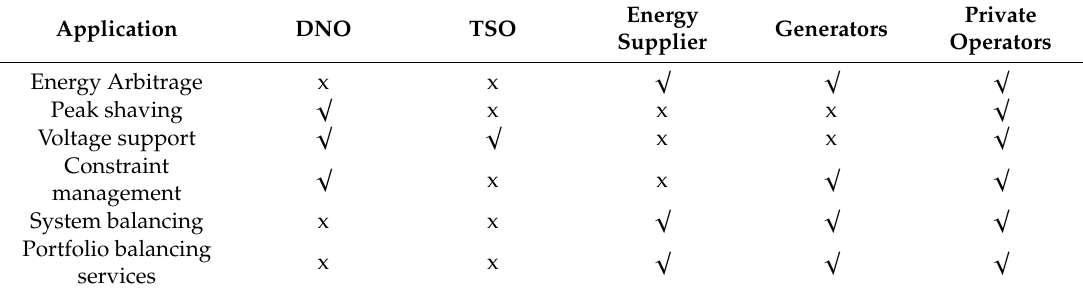
Table 4. ES applications mapped to electricity industry actors